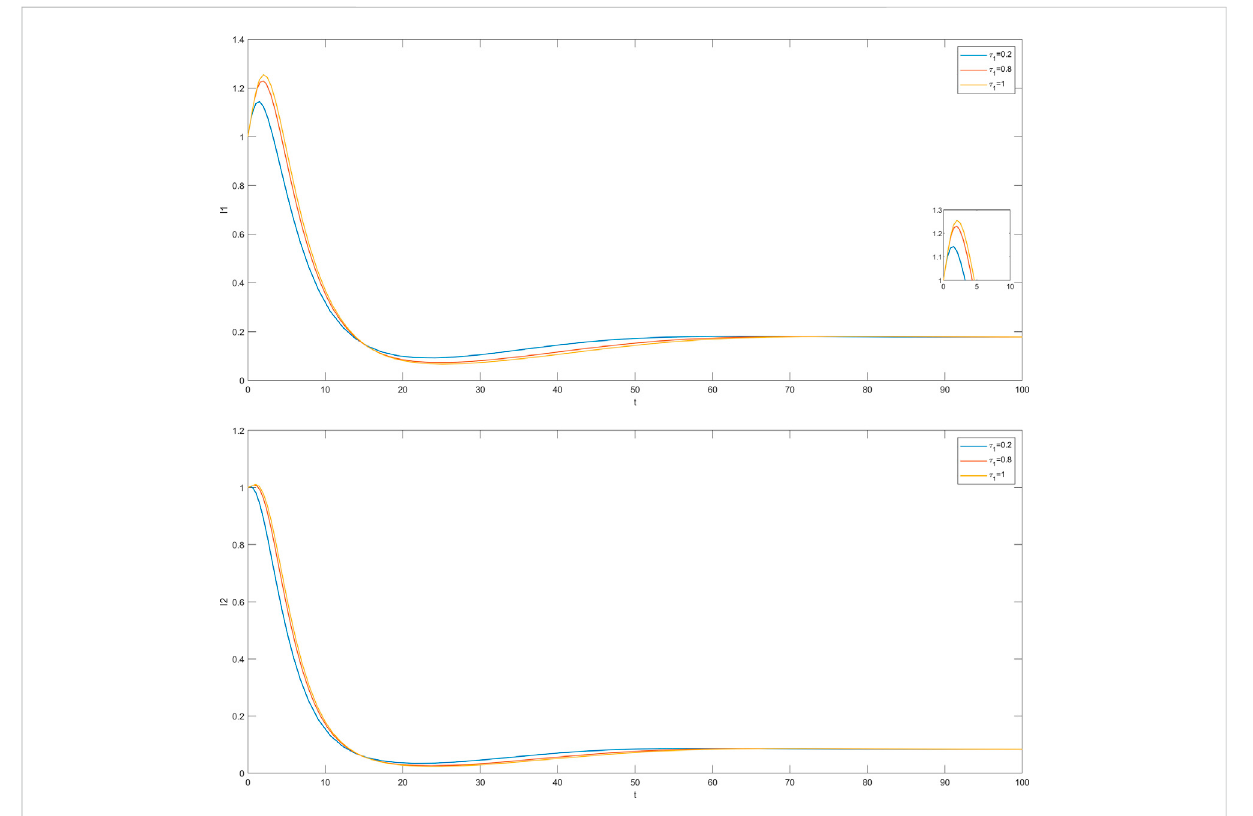
FIGURE 6 Trends of I 1 and I 2 with different time delays when R 0 >